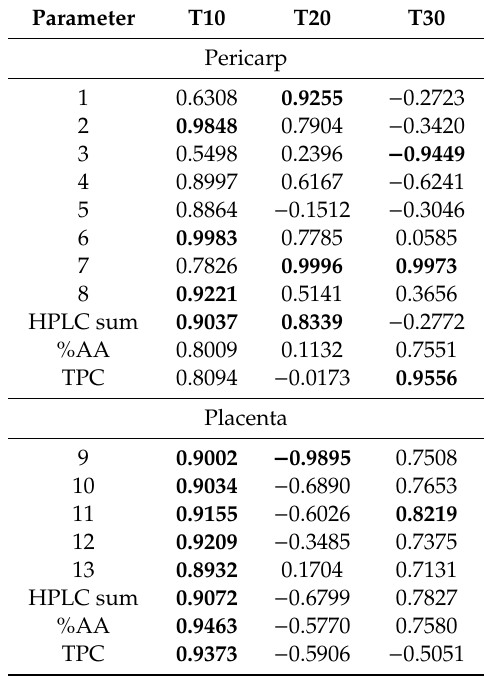
Table 2. Pearson’s correlation analysis of ozonation time and other tested parameters. Parameter